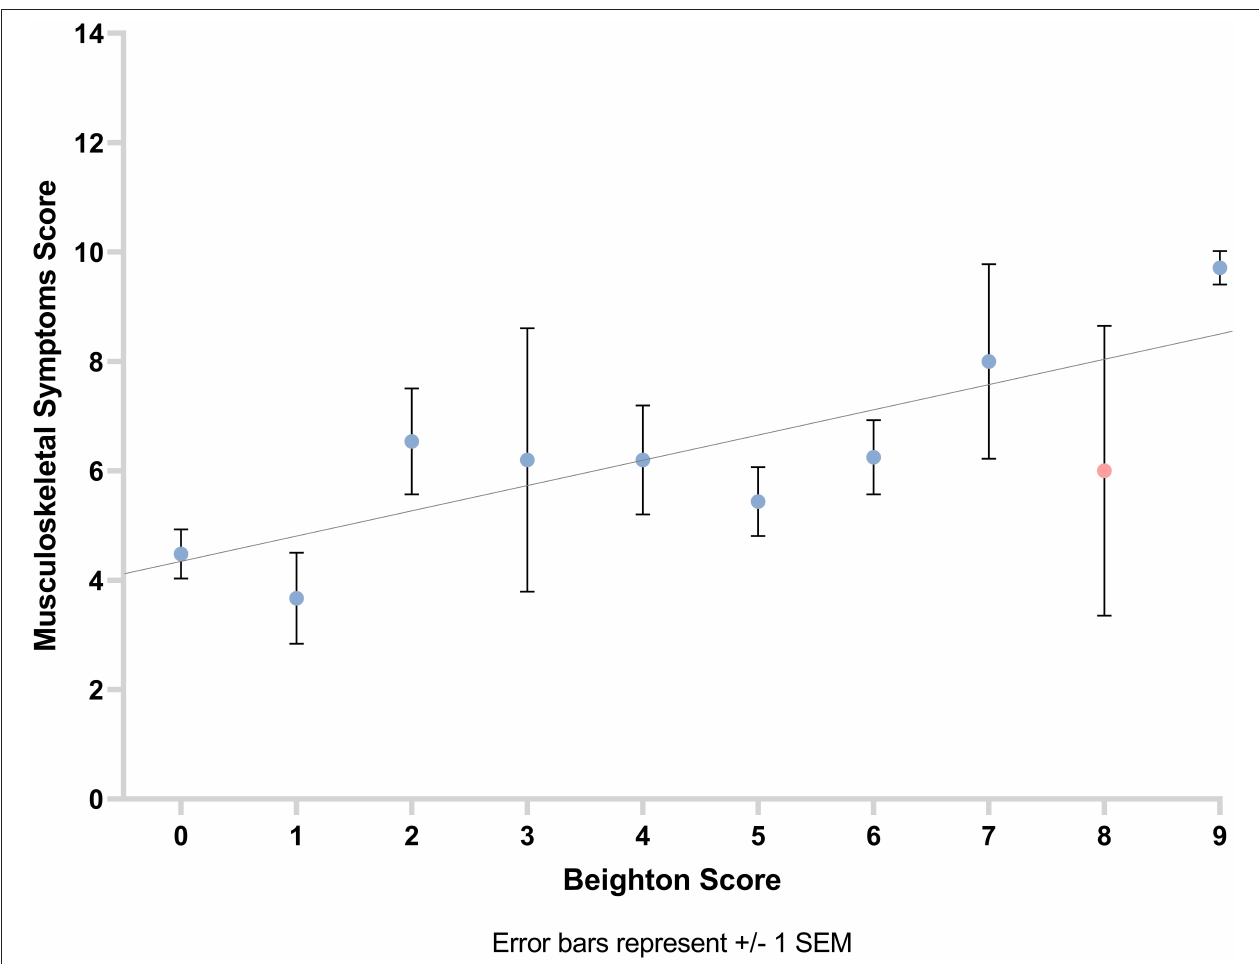
FIGURE 5 | Graph showing the relationship between musculoskeletal symptom score and Beighton score with line of best fit. Error bars show ± 1 standard error of the